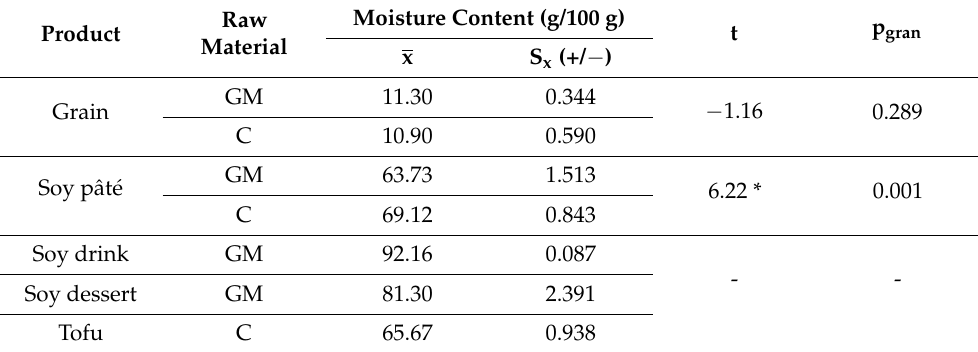
Table 5. Moisture content in soybean grain and soy